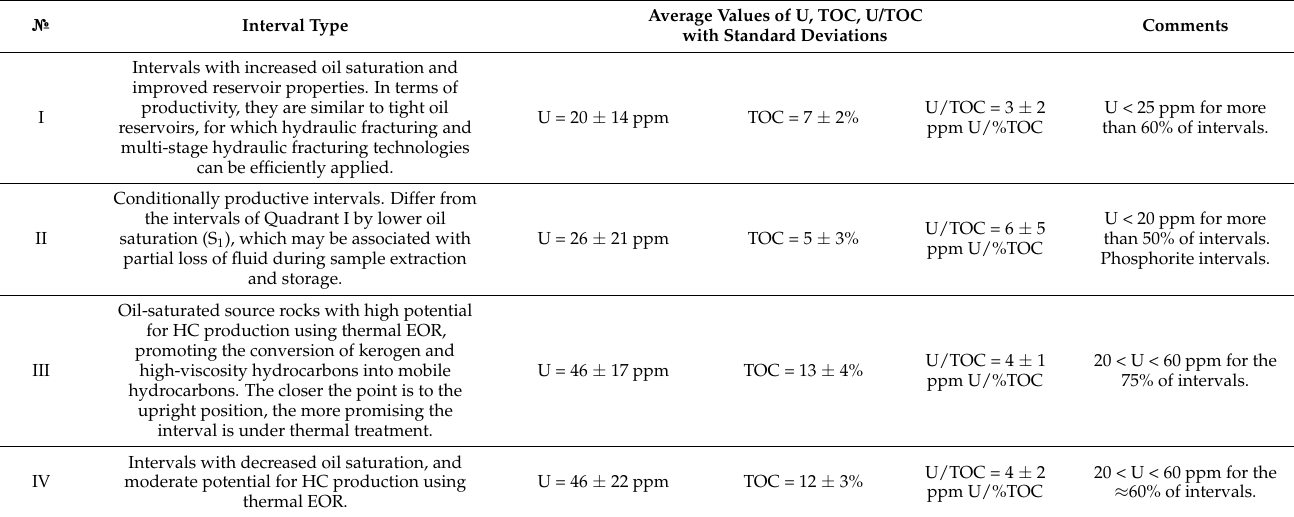
Table 3. Types of productive intervals as a function of uranium and total organic carbon, U/TOC